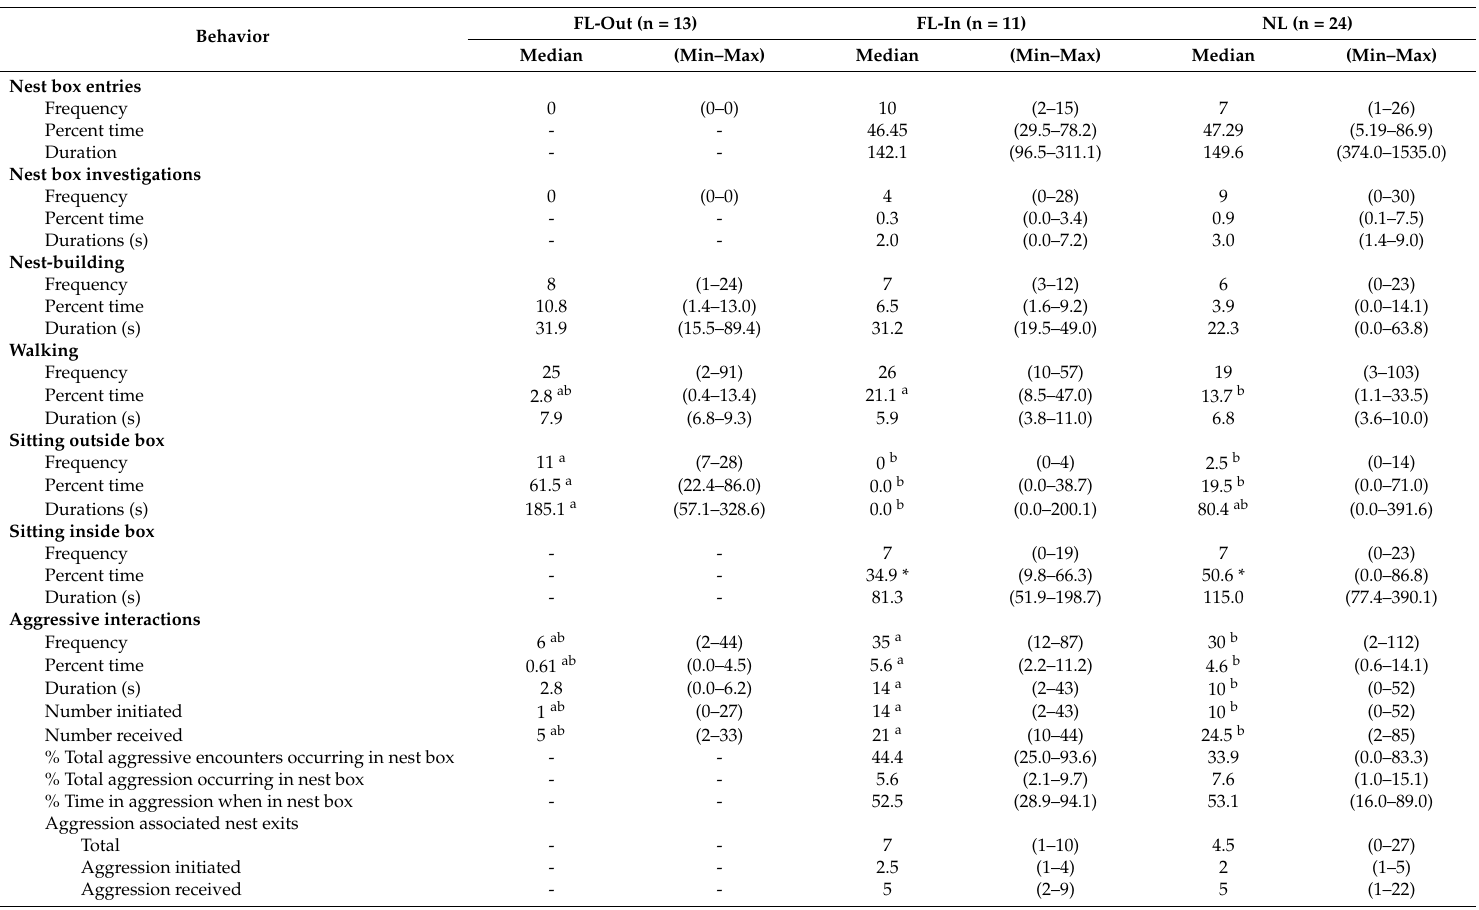
Table 2. Frequency, percentage of time spent and duration (s) of behaviors performed by laying Pekin ducks in the hour prior to oviposition site selection. FL-Out = ducks that floor-laid and did not enter nest boxes; FL-In = ducks that floor-laid but did enter nest boxes; NL = ducks that laid in nest boxes. Values are median values, with the minimum and maximum range in brackets. Values with different superscripts across rows are significantly different ( p ≤ 0.05). Values with * across rows show a trend towards significance (0.1 ≤ p >